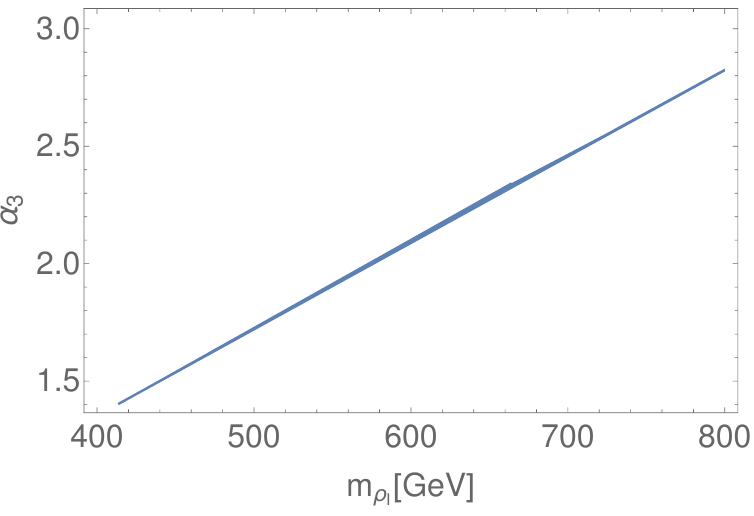
Figure 10 . Correlation between the quartic scalar coupling α 3 and the mass m ρ Matter candidate ρ I , consistent with the experimental value Ω h 2 = 0 . 1198 for the Relic density.